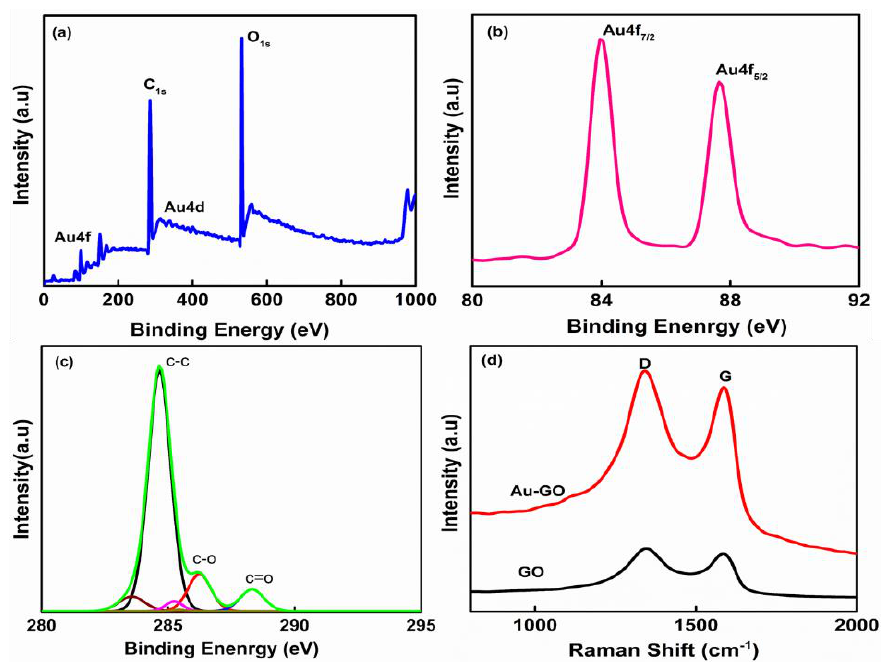
Figure 3. X-ray photoelectron spectroscopy (XPS) and Raman spectra of the Au-GO nano-hybrid. ( a ) Wide scan spectra; ( b ) Au4f spectrum; ( c ) C1s spectrum; ( d ) Raman spectra of the Au-GO and GO.